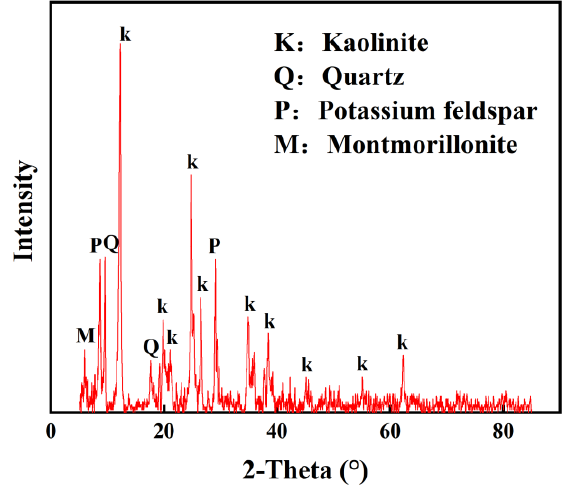
Figure 2. XRD pattern of the original kaolinite.